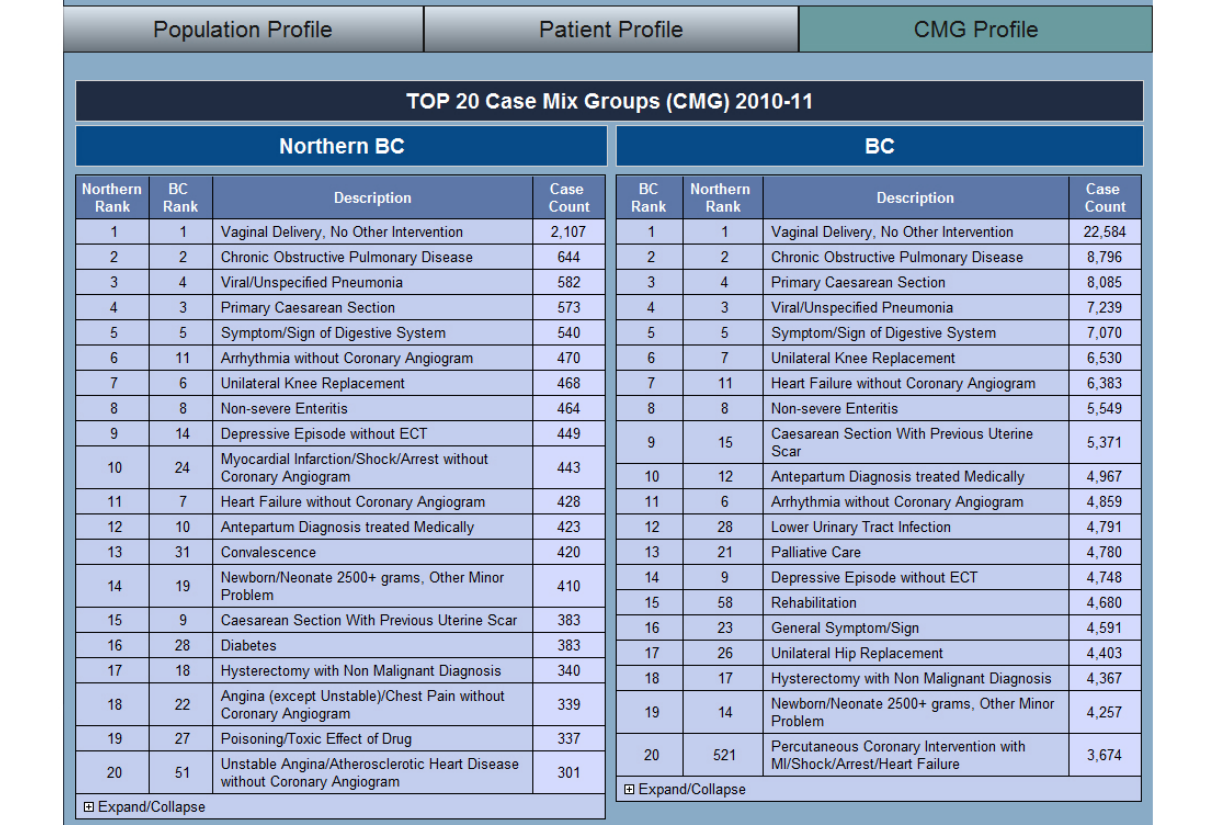
Figure 5. Main dashboard: Case Mix Groups (CMG)